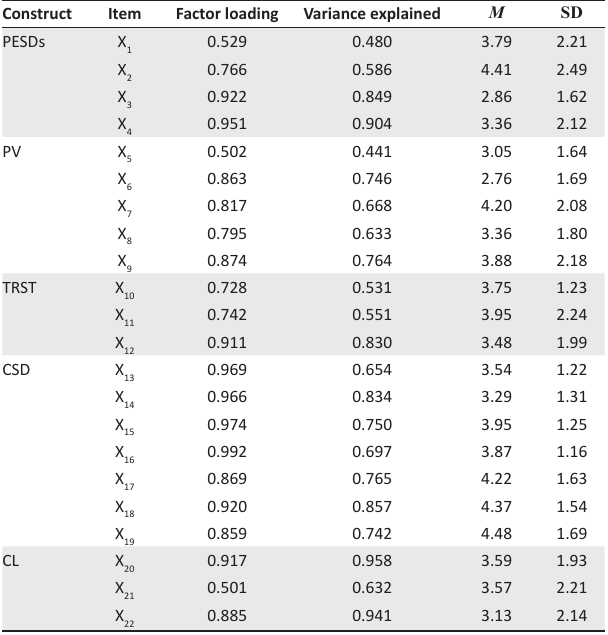
TABLE 3: Factor loadings, variance explained, means ( M ) and standard deviations (SDs). Construct